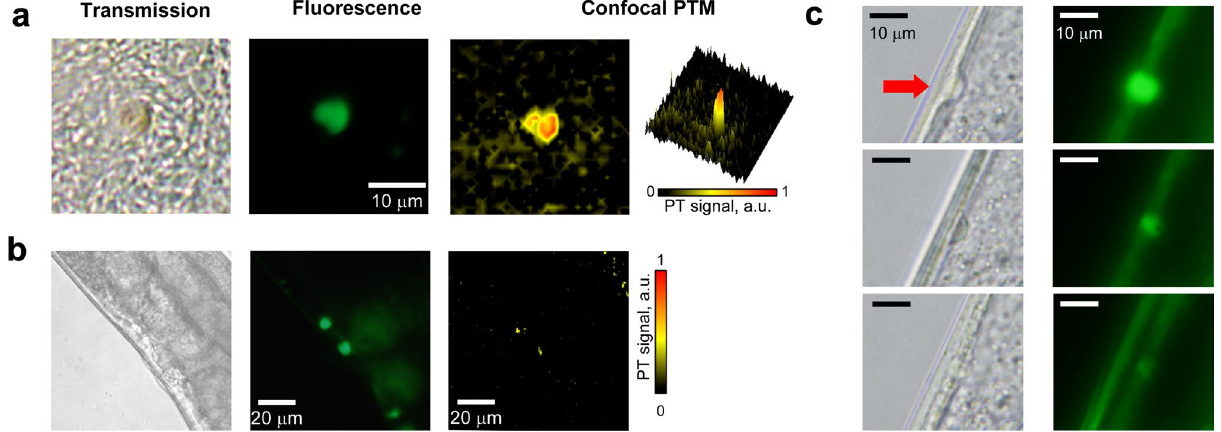
Figure 2. High resolution imaging of polyQ-YFP aggregates using transmission, fluorescence (YFP), and confocal PTM modalities. ( a ) Ex vivo, aggregates were separated from crushed worms prior to laser exposure. ( b ) In vivo, within a live worm. ( c ) Decreased fluorescence and changes in shape of a protein aggregate after laser therapy in vivo (top row—before therapy; middle and bottom rows—after 20 and 30 laser pulses, respectively, at 430 nm, 1 µJ/pulse; ×100 focusing